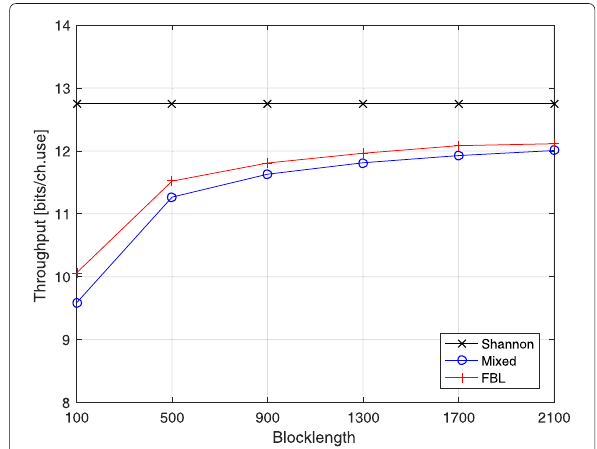
Fig. 4 Throughput vs. blocklength with target error probability (cid:5) = 10 −